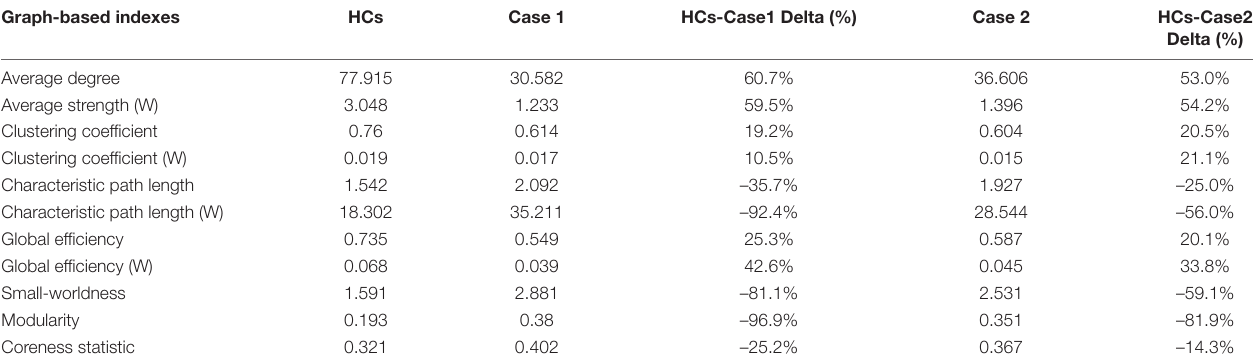
TABLE 1 | Global graph-based topological properties of the HC template and the two stroke cases. Reported Delta values were computed as (HC-Case)*100/HC. Graph-based